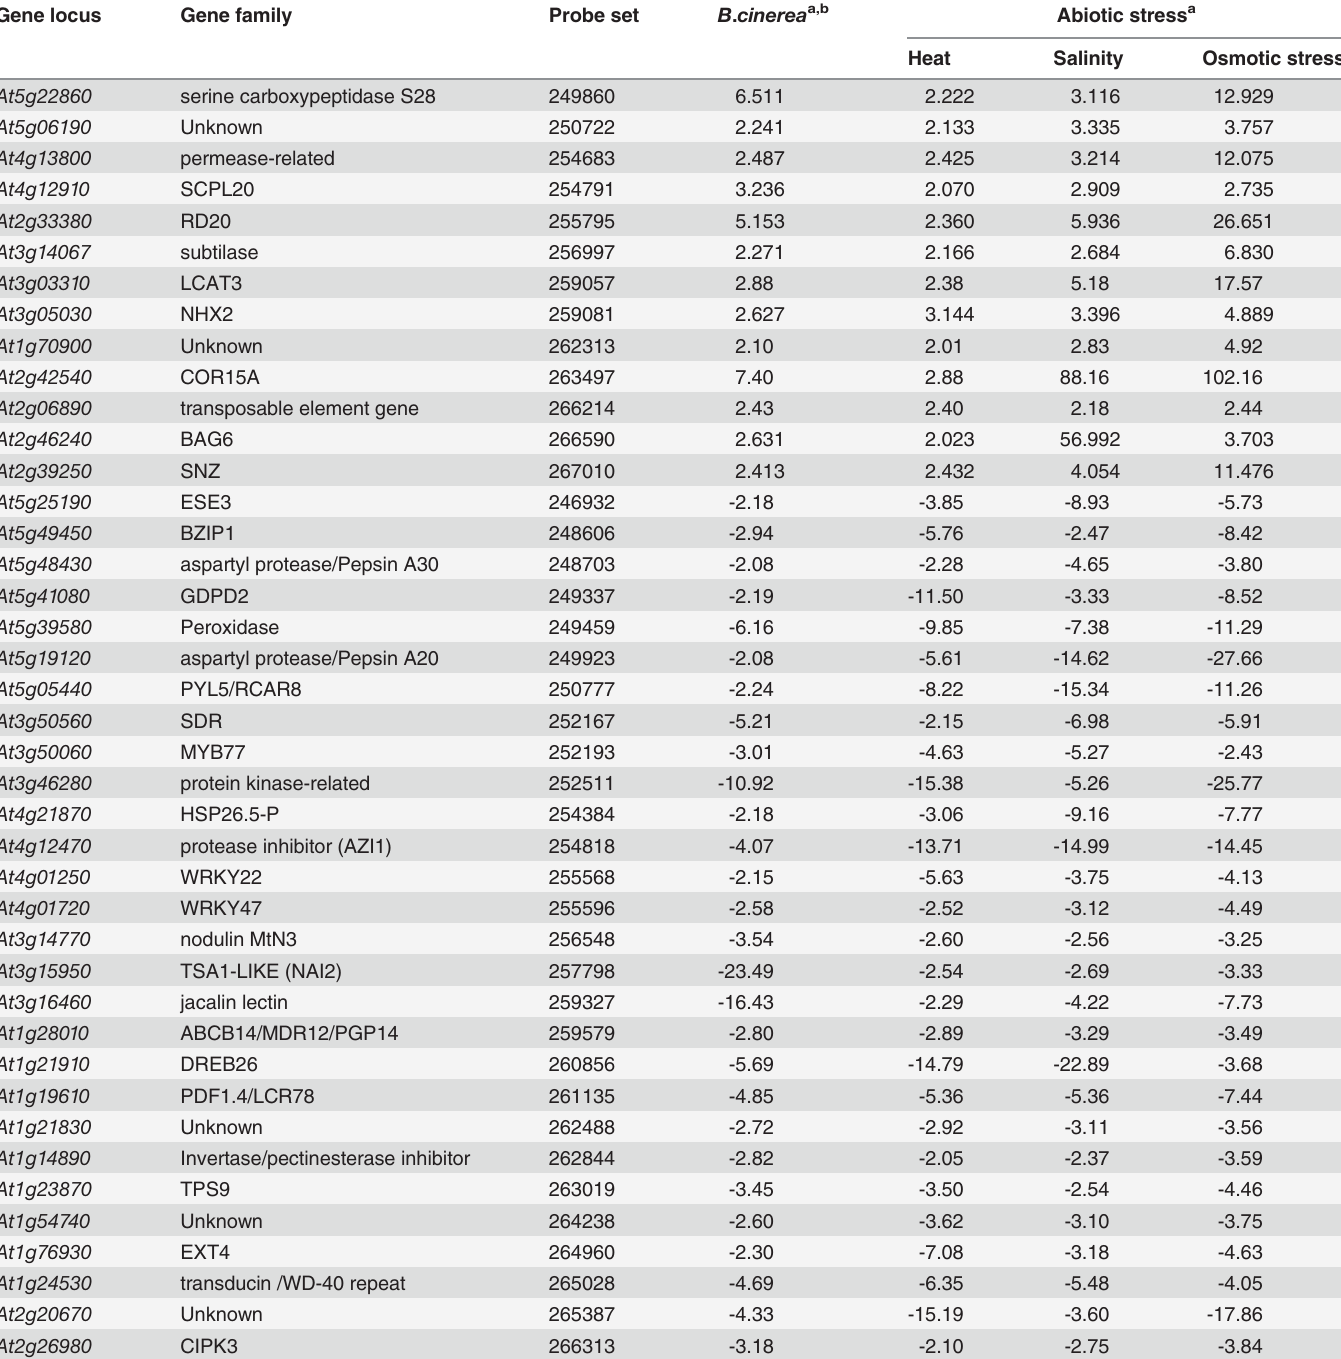
Table 2. Changes in expression of up-/down-regulated genes encoding putative proteins during B . cinerea infection and heat, salinity, and osmot- ic stress treatments in wild-type Arabidopsis plants. Gene